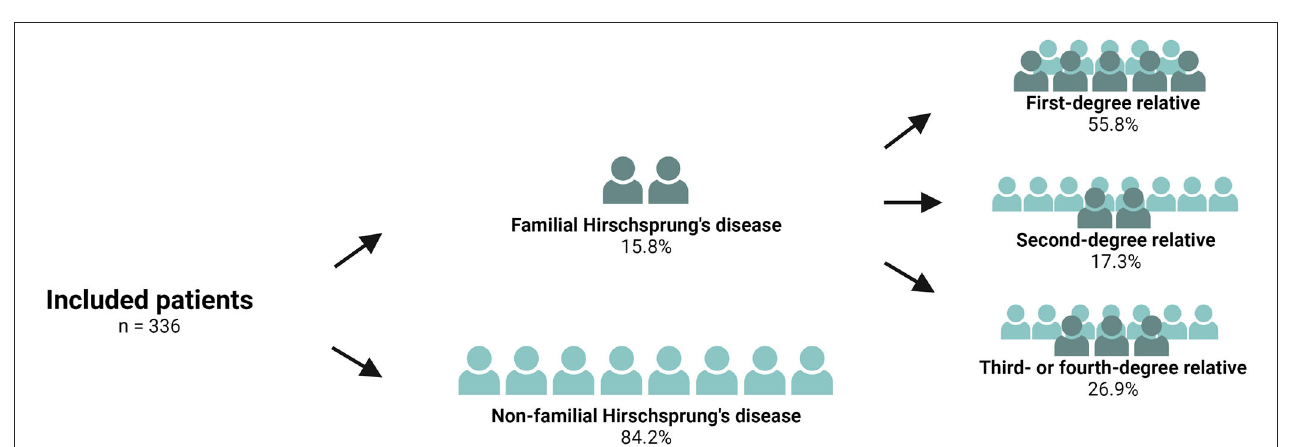
FIGURE 2 | Flowchart of the included patients with familial and non-familial Hirschsprung’s